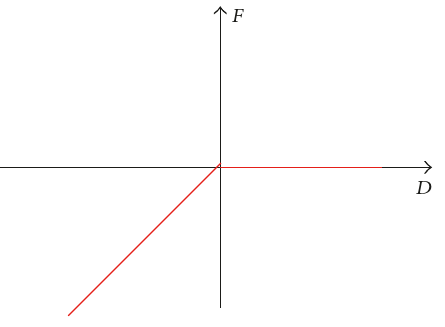
Figure 3: 𝐹 - 𝐷 curve for COMBIN39